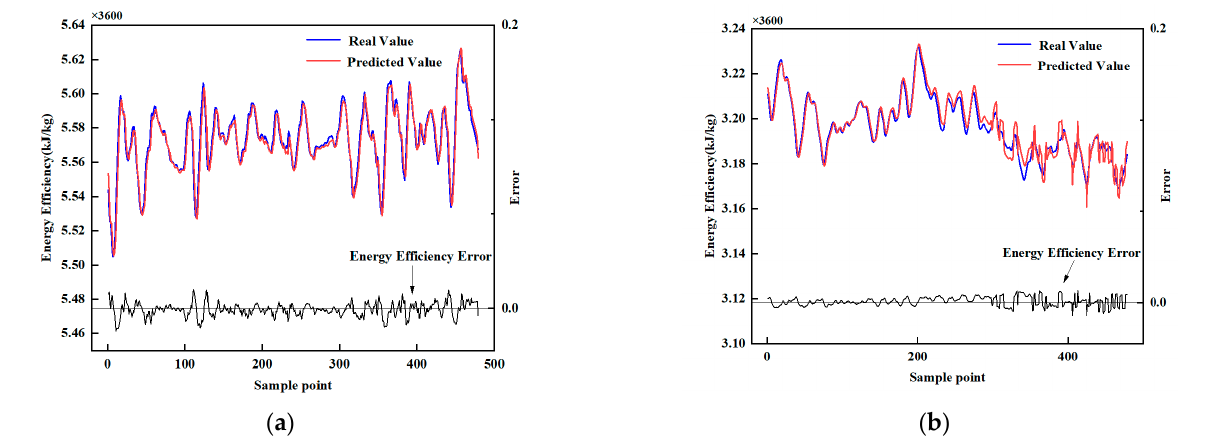
Figure 12. Product energy-efficiency prediction of working condition 1. ( a ) Prediction of energy efficiency of atmospheric two-line products. ( b ) Prediction of energy efficiency of vacuum two-line product.